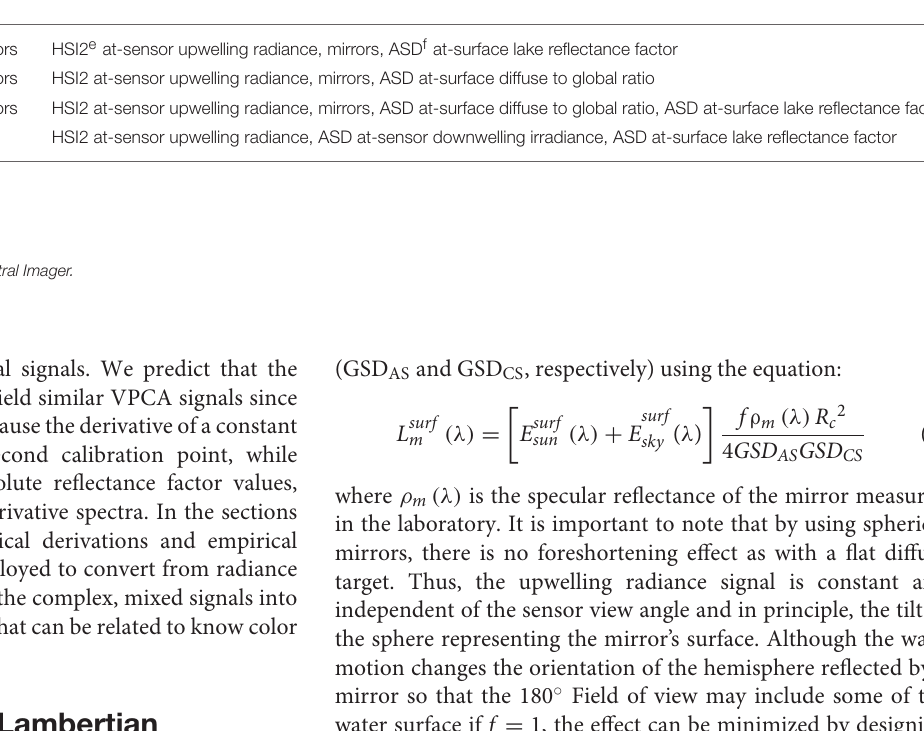
TABLE 1 | Reflectance calibration methods employed.